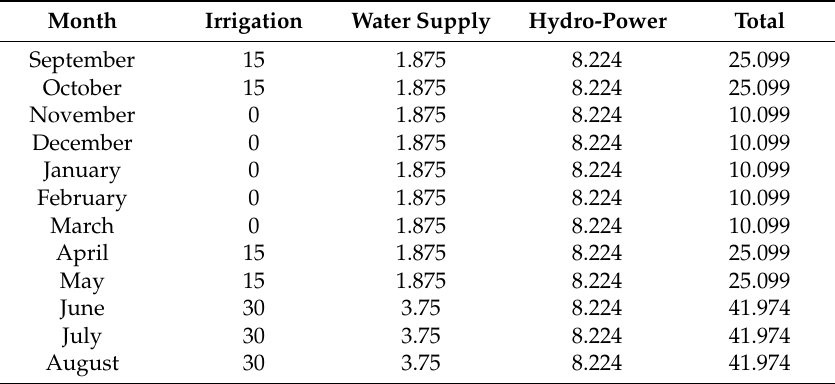
Table 4. Monthly water demands (10 6 × m 3